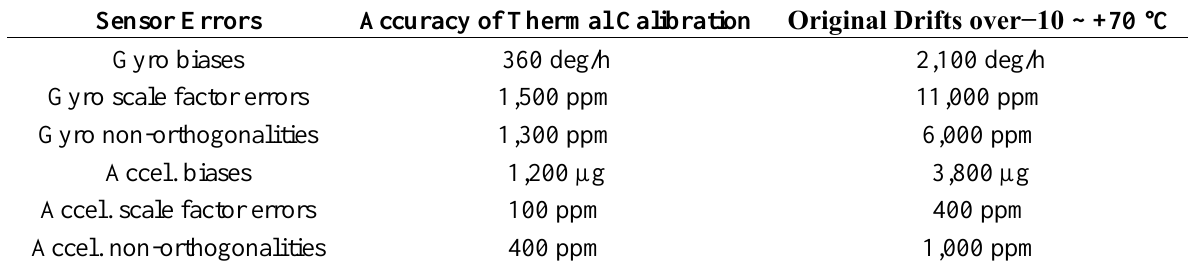
Table 5. Calibration accuracy of proposed method (reference to Soak method) and the original thermal drift levels of the IMU errors over the whole temperature range (with